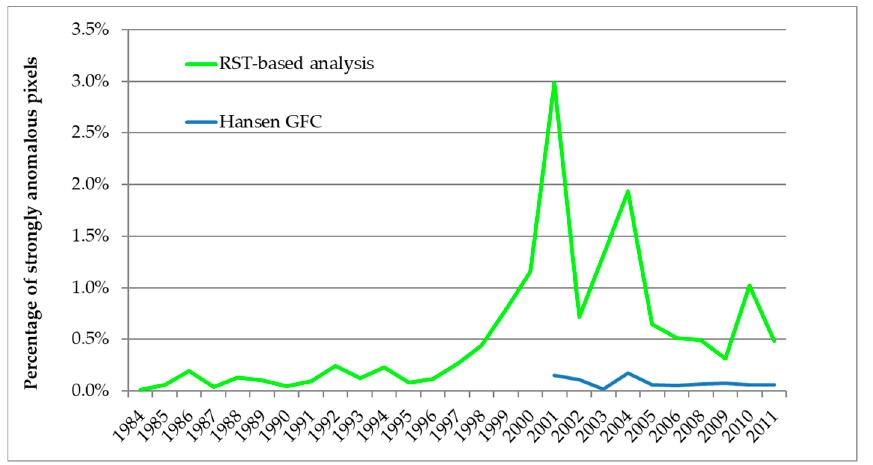
Figure 9. Percentage of pixels with strongly negative ALICE values ( ⨂ NDVI_MVC ( x , y , t ′ ) ≤ − 3) in the oak forests of the Basilicata region (green line) and corresponding percentage of forest loss per year according to the Hansen Global Forest Change product [50] (blue line).